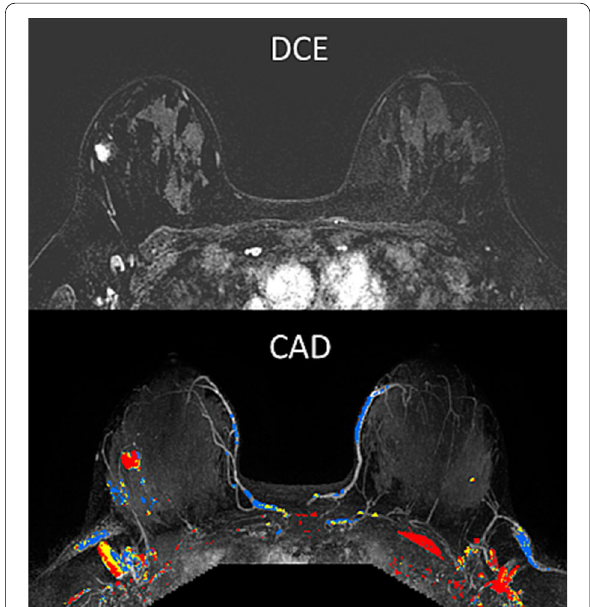
Fig. 13 Preoperative MRI during lactation. Axial subtracted DCE‑MRI and CAD images of a 37‑year‑old PABC patient, lactating for 3 months are shown. Note : DCE reveals the presence of a single small lesion in the right upper outer quadrant (12 mm IDC) with excellent conspicuity, comparing with the surrounding moderate BPE. The tumor exhibited the suspicious wash‑out pattern (red) on CAD MIP image, while slight BPE exhibited persistence benign wash‑in pattern (blue)